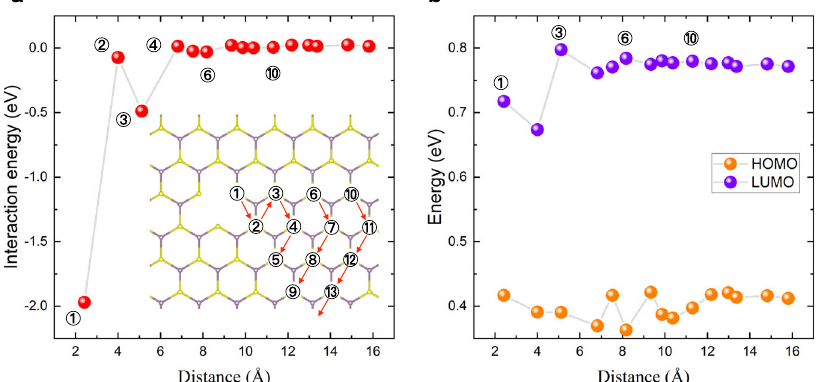
Fig. 3 The fl uctuation of defect properties. The a interaction energy, b HOMO, and LUMO for V2 defects as a function of the distance between the Mo vacancy and the S vacancy. The inset labels the positions of the nearest S sites to the Mo